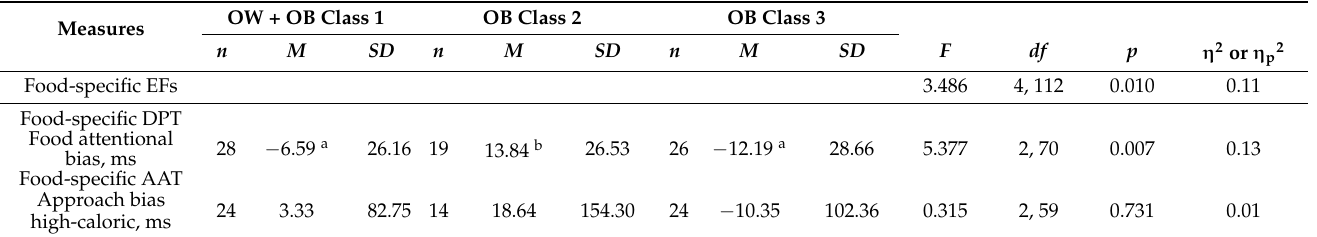
Table 2. Means, standard deviations, and multivariate and one-way analyses of variance in measures of food bias by weight